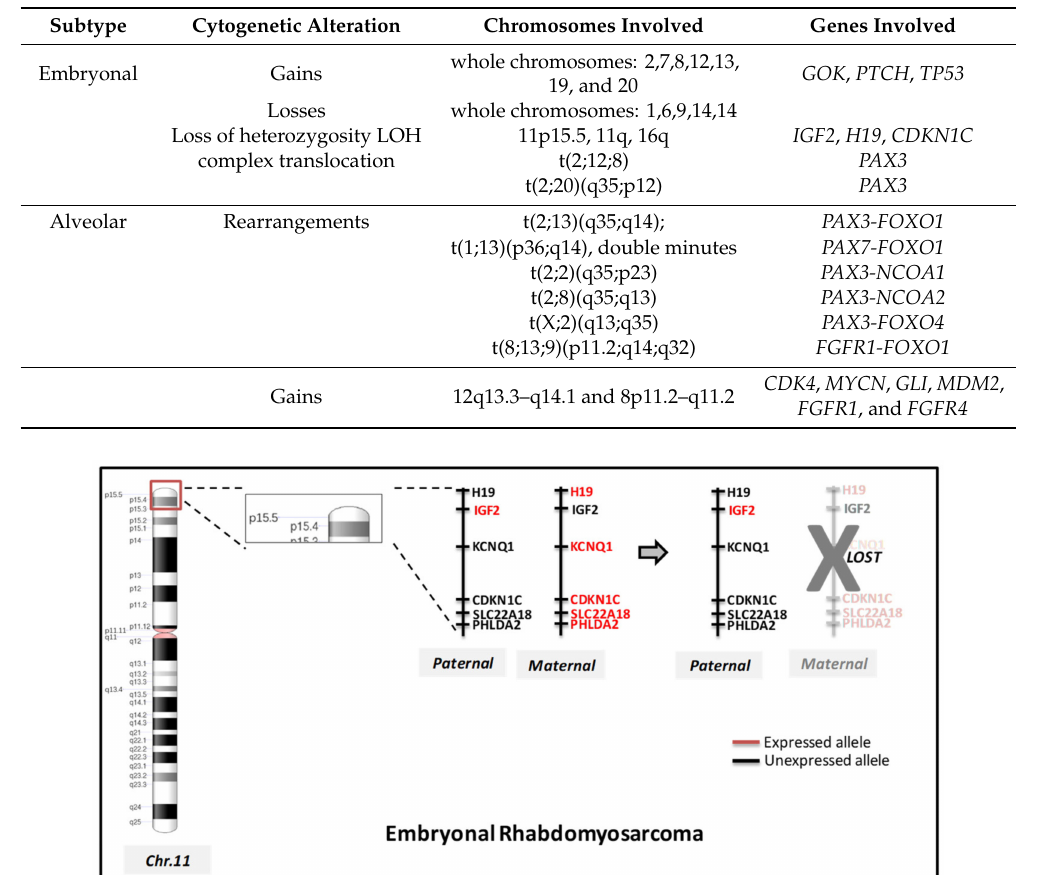
Table 1. Cytogenetic alterations in Rhabdomyosarcoma RMS.